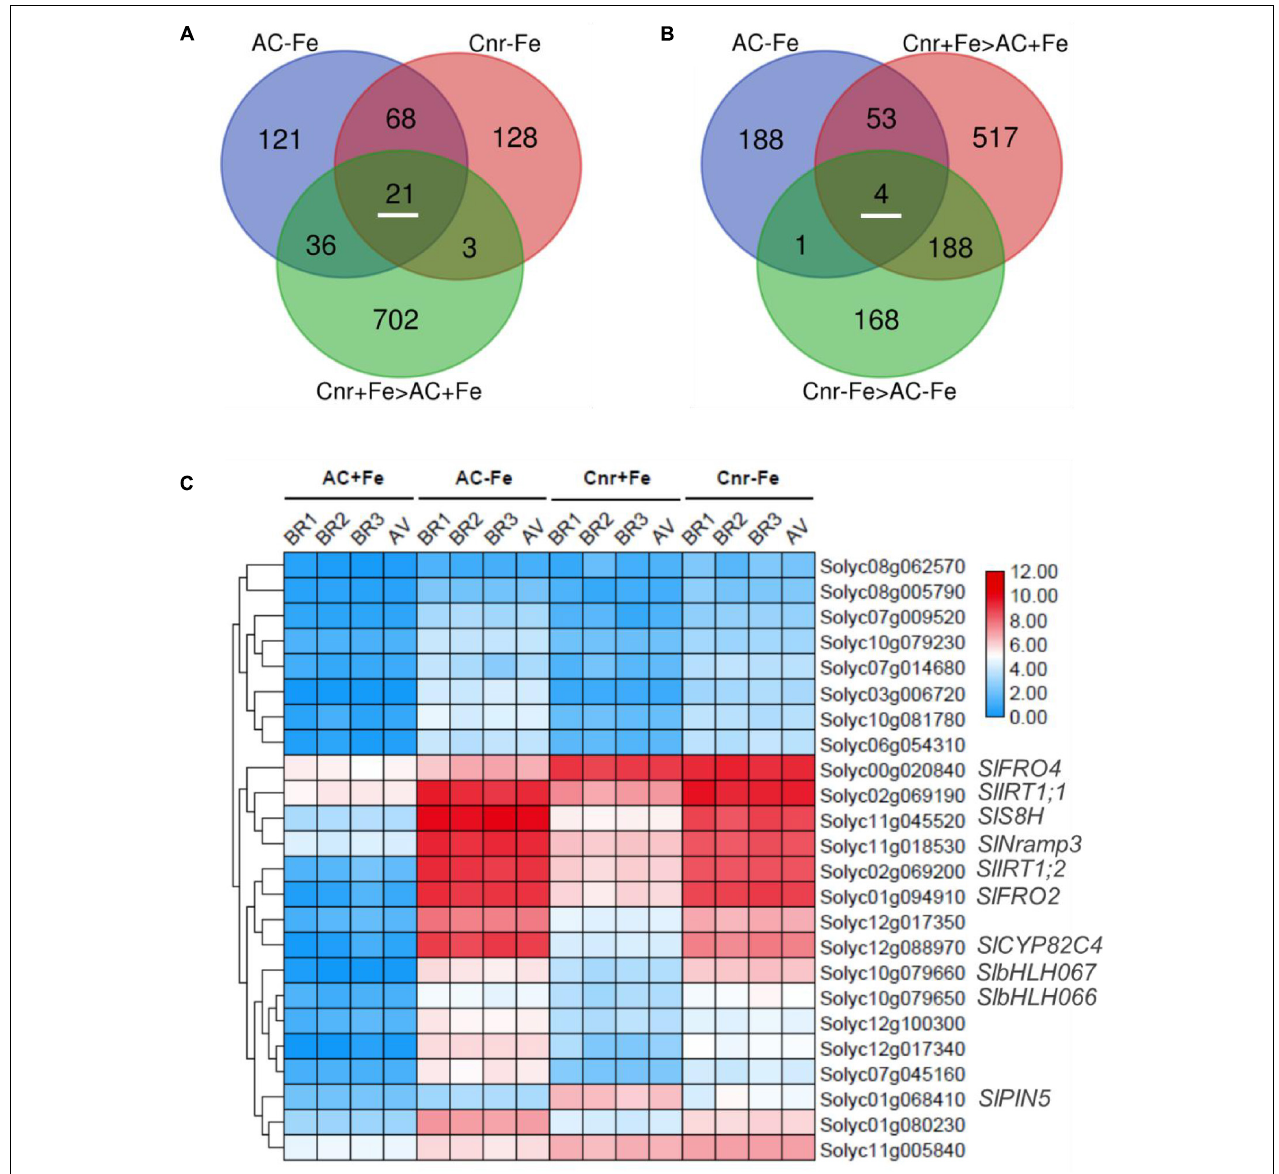
FIGURE 2 | Identification of potential Cnr -mediated Fe-deficiency-responsive genes. (A) Venn diagram shows 21 Fe-deficiency-responsive genes whose expression could be constitutively induced by Cnr epimutation under Fe-sufficient condition. (B) Venn diagram shows 4 Cnr -mediated Fe-deficiency-responsive genes whose expression was higher in Cnr epimutant than that in AC under Fe-deficient condition. (C) Expression profiles of potential Cnr -mediated Fe-deficiency-responsive genes. BR, biological replicate; AV, average